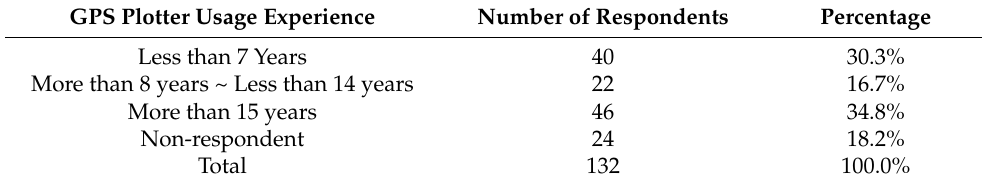
Table A1. Characteristic of respondents by the experience of GPS plotter